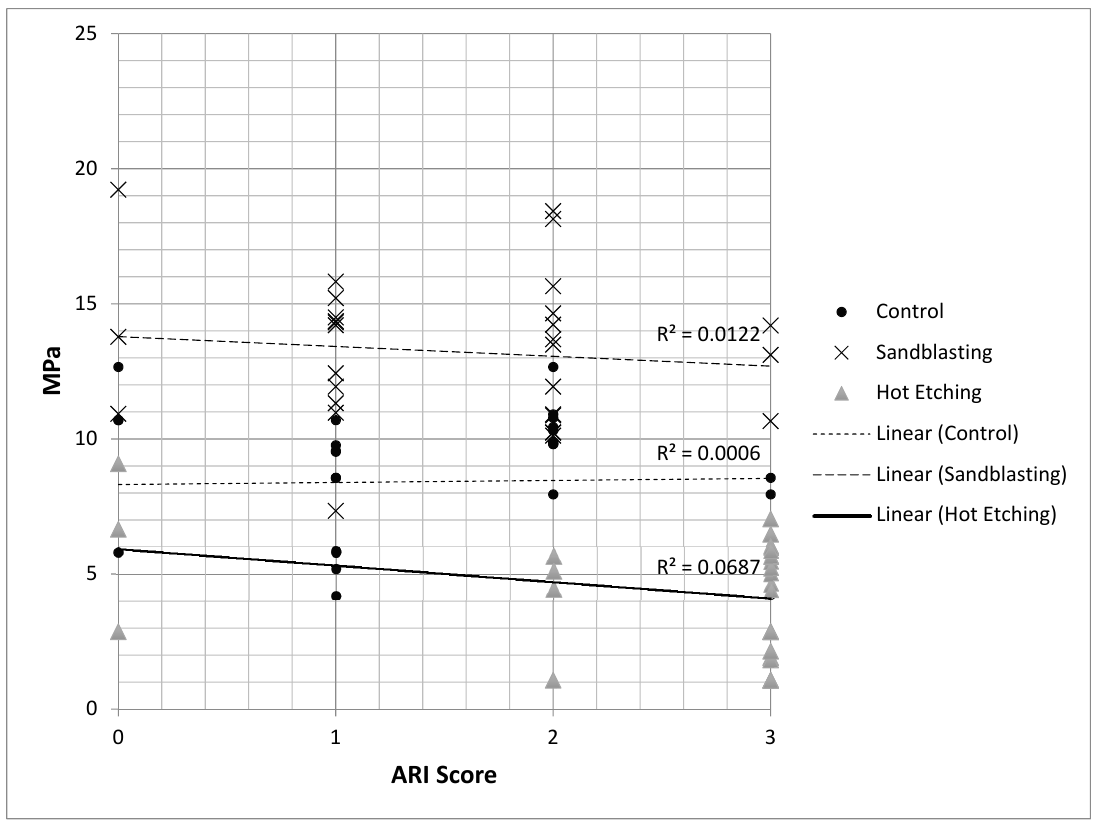
Figure 5. Correlation between adhesion strength (MPa) and adhesive remnant index (ARI score). No correlation between the two variables was recorded in the three different conditions tested (control, ABPA, and hot etching).